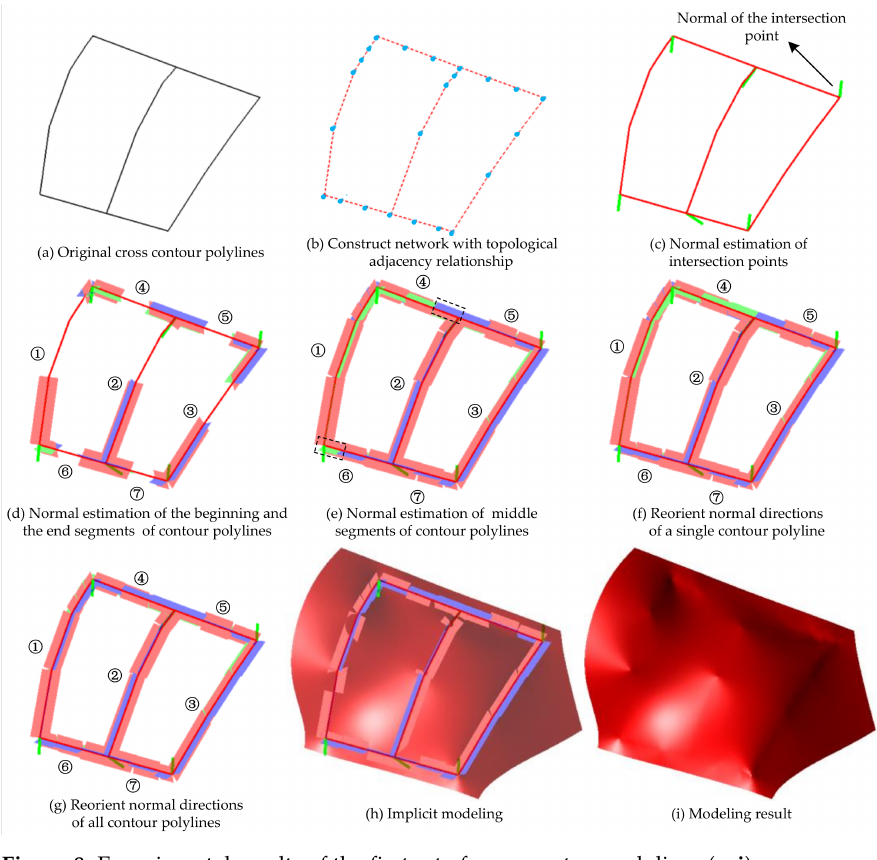
Figure 8. Experimental results of the first set of cross contour polylines ( a – i ).